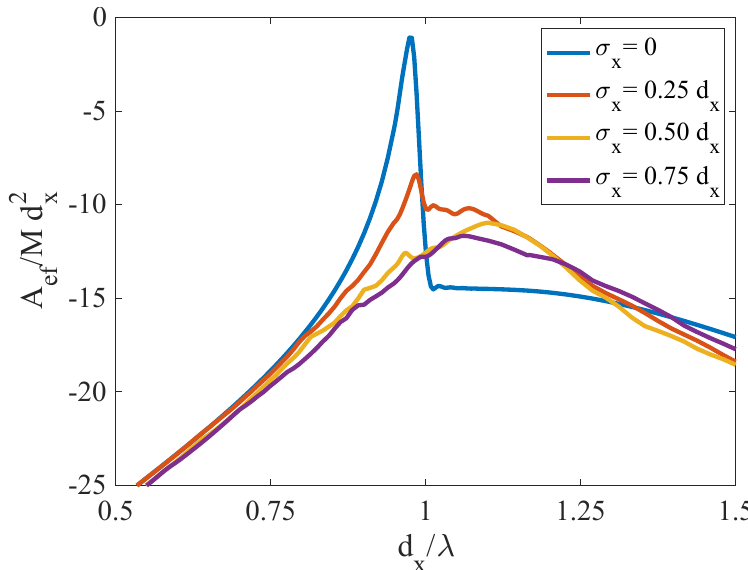
Figure 6. Normalized effective transmitting area of a finite chain of M slots with l s = 0.4 d x , w s = 0.05 d x and with x ci given by a set of random numbers following a normal distribution with mean id x for different values of standard deviation.